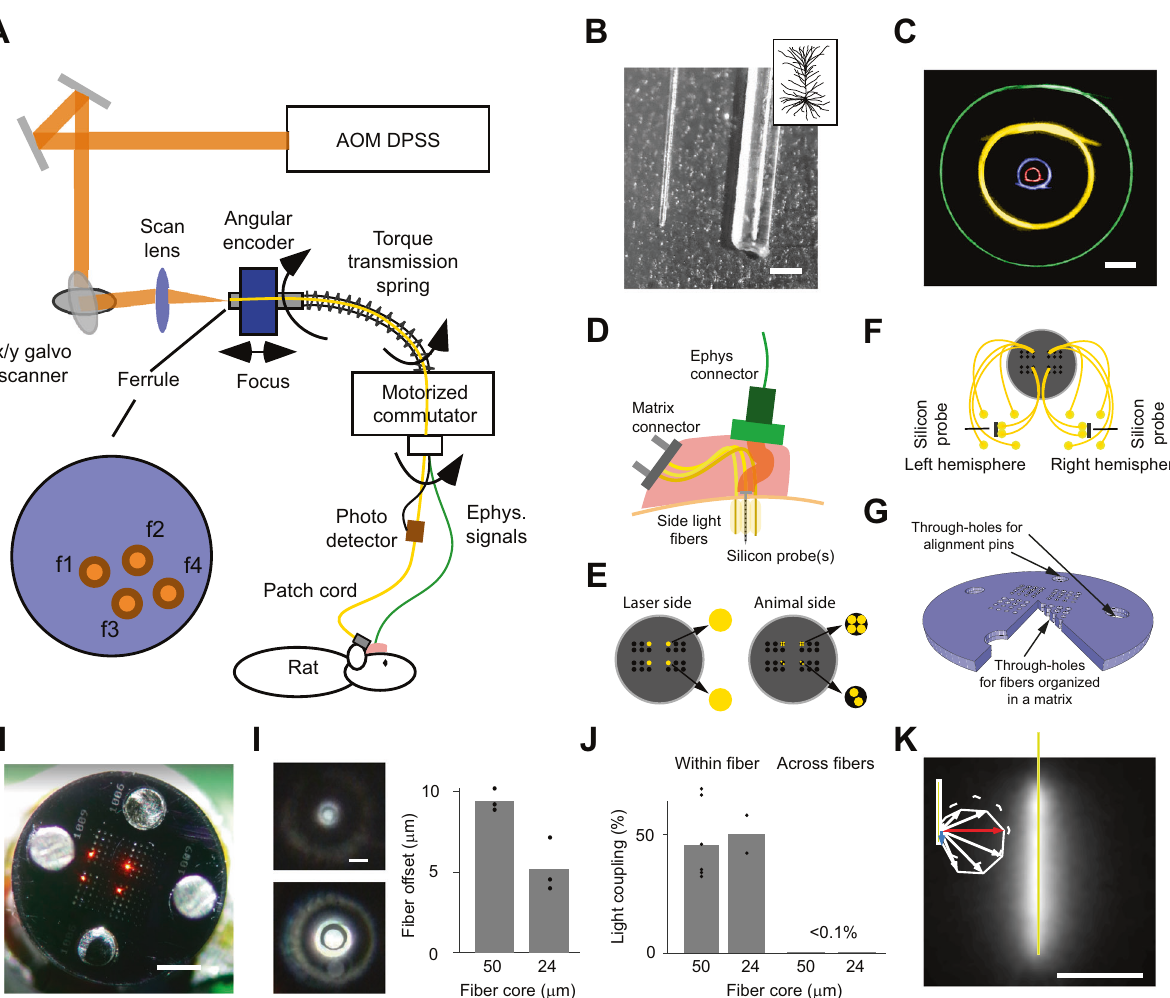
Fig. 1 Optical framework for applications of ultrathin fi bers with shaped pattern write-in in a freely moving animal. A Optical system for automatic fi ber bundle detection and optimized fi ber coupling from an acousto-optically modulated (AOM) diode-pumped solid-state (DPSS) laser. Feedforward control from the ferrule angle allows the galvo scanner to track one of the selected fi bers (f1, f2, f3, and f4) in a freely moving animal. B A 30 µ m fi ber next to a 230 µ m fi ber. Scale bar: 200 µ m. The inset depicts a neuron to illustrate the size relationship. C Minimal bending radius for fi bers with different outer/core diameter ratios: 230/200 µ m (yellow), 125/100 µ m (green), 65/50 µ m (blue), and 30/24 µ m (red). Scale bar: 2 mm. D Implantation schematics. The fi bers (yellow), matrix connector (gray), electrode ribbon cables (orange/red), and electrode holder (green) were all cemented (pink) to the bone. E Coupling from 60 µ m fi ber (large fi lled yellow circle) on the laser side to two or four 30 µ m fi bers (small fi lled yellow circle) on the animal side. F Topological relation between implanted fi bers and fi ber-matrix connector. The through-hole was 75 μ m in diameter, which allowed us to insert four 30 µ m fi bers. G Simpli fi ed 3D schematic illustration of the circular fi ber-matrix connector plates, with a triangular cutout to illustrate the cross-section through the 380 µ m-thick plate, created in silicon using microsystems processing (four 4 × 4 arrays are shown for improved visibility; the actual connector had four 6 × 6 arrays). H Photograph of fi ber-matrix connector. Fibers were reverse-illuminated to visualize their location in the fi ber-matrix connector. Scale bar: 1 mm. I Left: Fiber hole alignment for a 30/24 µ m outer/core diameter fi ber (top) and a 65/50 µ m outer/core diameter fi ber (bottom). Scale bar: 50 µ m. Right: Quanti fi cation of the offset between two connector plates for two different hole sizes for 30 µ m-diameter fi ber (24 µ m core) and 65 µ m-diameter fi ber (50 µ m core). J Connector transmission ef fi ciency and crosstalk between neighboring fi bers in the connector. K Coated 2 mm fi ber in milk. Scale bar: 1 mm. Note that, among the different emission directions tested (white, blue, and red arrows), the radial side-emitted component (red arrow) is larger than the axial-forward component (blue arrow). Source data are provided as a Source Data fi